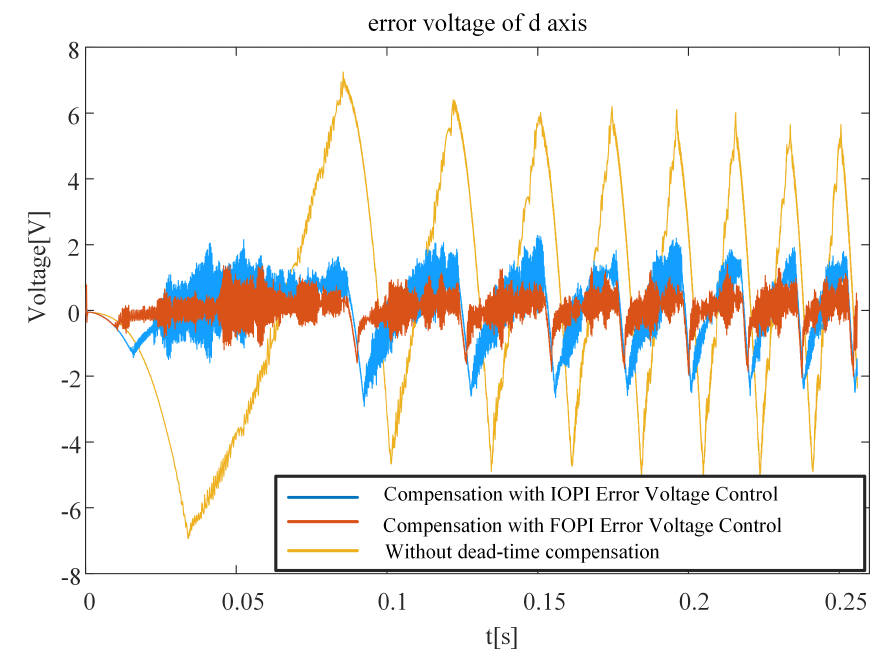
Figure 17. Comparison of the error voltage of d-axis in the